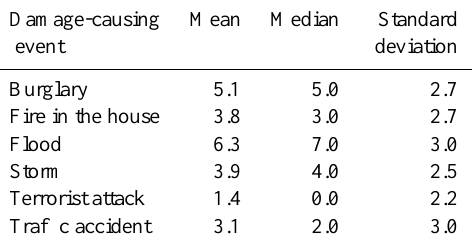
Table 2. Respondent’s ratings of the perceived likelihood that sev- eral harmful events cause damage to their property ( n = 187 to